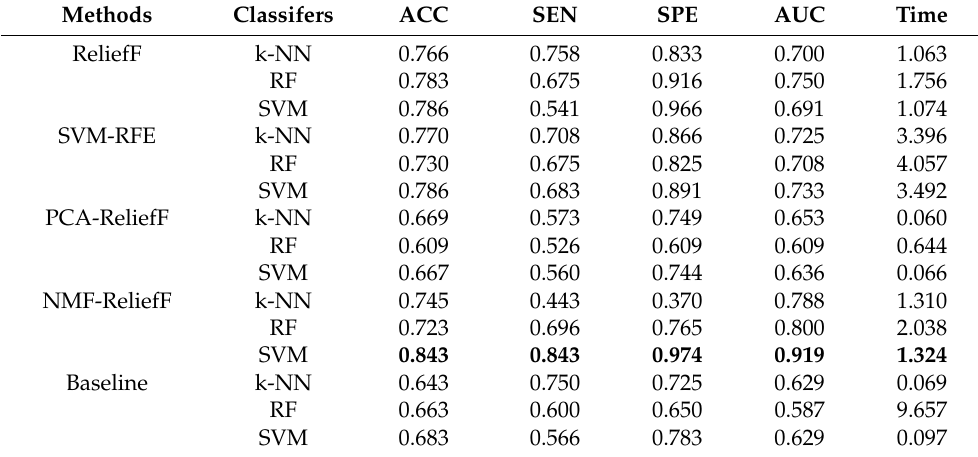
Table 3. Comparison of our method, ReliefF, SVM-RFE, and PCA-ReliefF on matrix of gene family data set; the best result is in bold